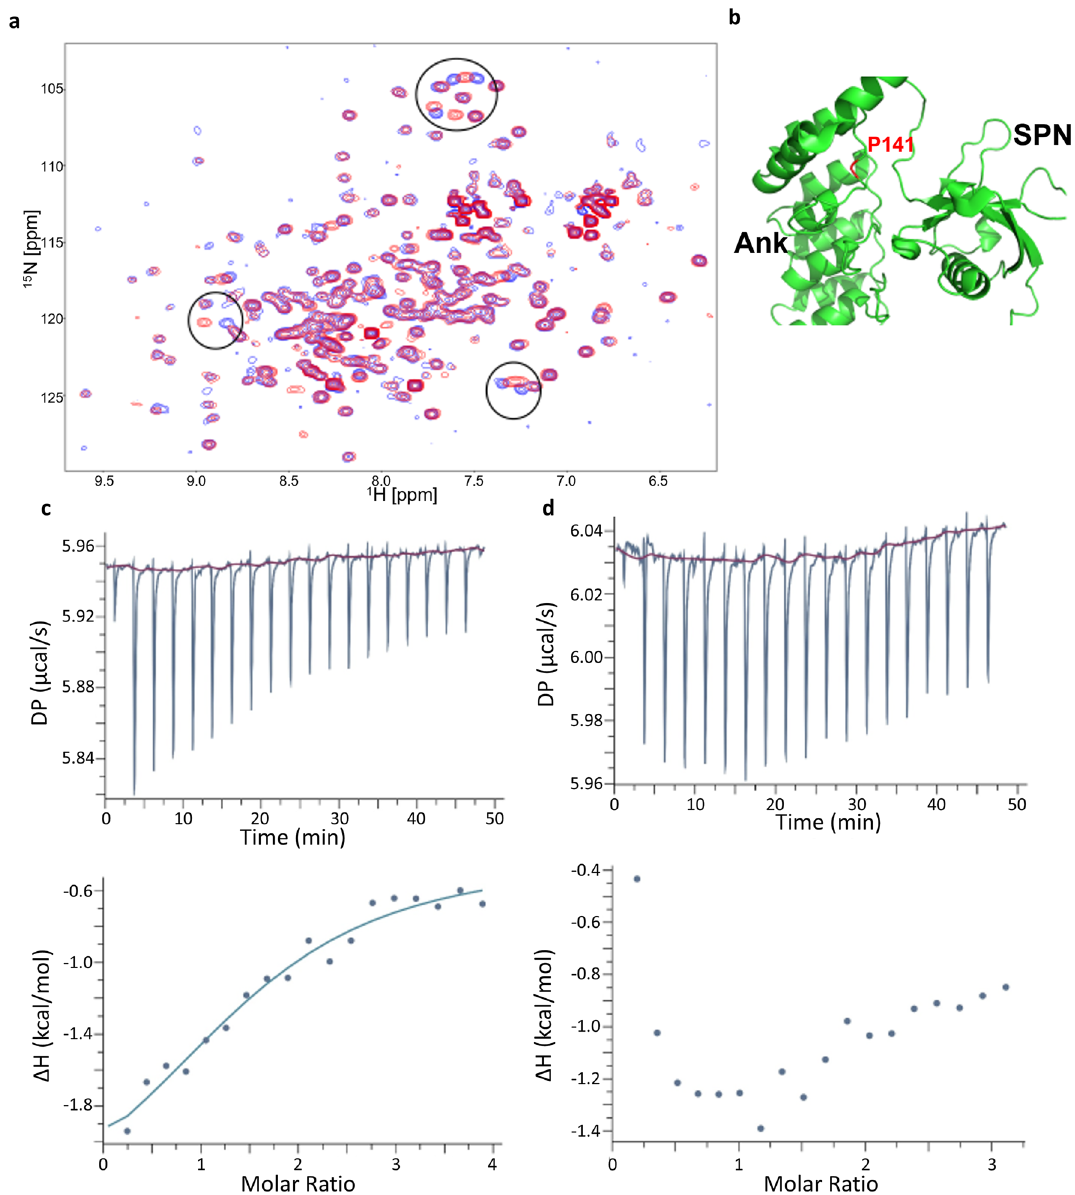
Figure 6. Effect of P141A mutation on Shank3 Ank domain. ( a ) Superposition of the 1 H, 15 N-HSQC NMR spectra of WT Ank (blue) and P141A Ank (red) domains of Shank3 measured at concentrations of 0.25 mM in the buffer containing 20 mM Tris pH 7.5, 1 M NaCl and 0.5 mM TCEP. Circles highlight the main differences between the spectra. ( b ) Structure of the SPN − Ank fragment (PDB ID 5G4X) showing position of P141 (red) at the interface between SPN and Ank domains. ( c + d ) ITC titration and isotherm for the interactions between isolated SPN and WT Ank ( c ) and P141A Ank ( d ) domains of Shank3. Solid line in c represents fitting to the single-site-binding model with a Kd of 19 µM and ΔH = -3.7 kcal/mol. No binding was detected for the P141A mutant ( d ). ITC titrations were performed at 25 °C with 25 µM of SPN in the cell and 400 µM of WT Ank or P141A Ank in the syringe. The buffer contained 20 mM Tris pH 7.5, 1 M NaCl and 0.5 mM